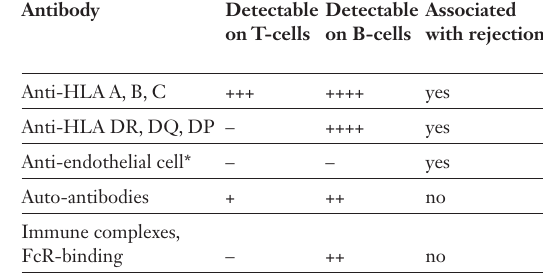
Antibodies detectable on T-/B-lymphocytes and their clinical relevance.